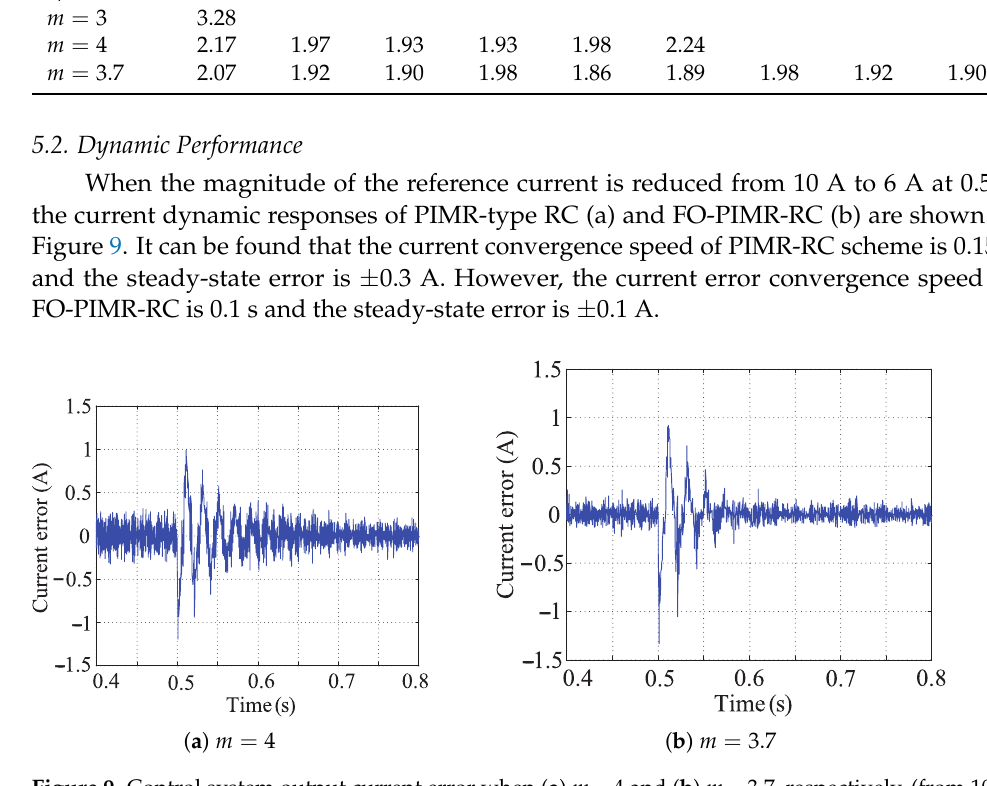
Figure 9. Control system output current error when ( a ) m = 4 and ( b ) m = 3.7, respectively, (from 10 A to 6